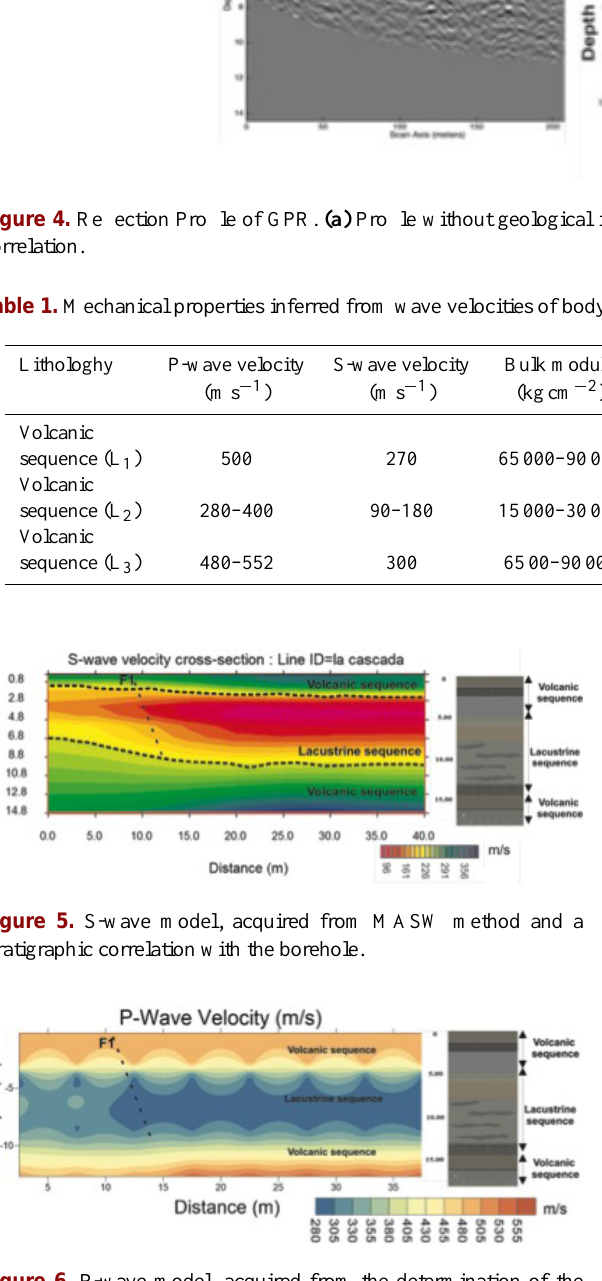
Figure 6. P-wave model, acquired from the determination of the first arrivals method and a stratigraphic correlation with the bore- hole. SR